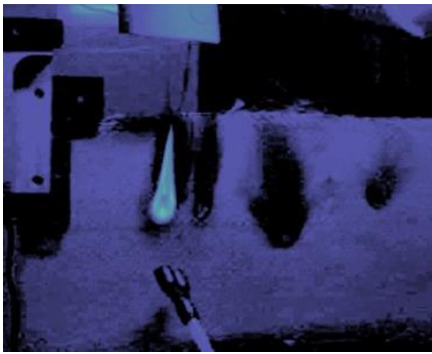
Figure 7. Flames erupting from the GF composite at t ≈ 30 s during a direct laser strike on the sensor at position 4. The N 2 nozzle can be seen just below the flame.